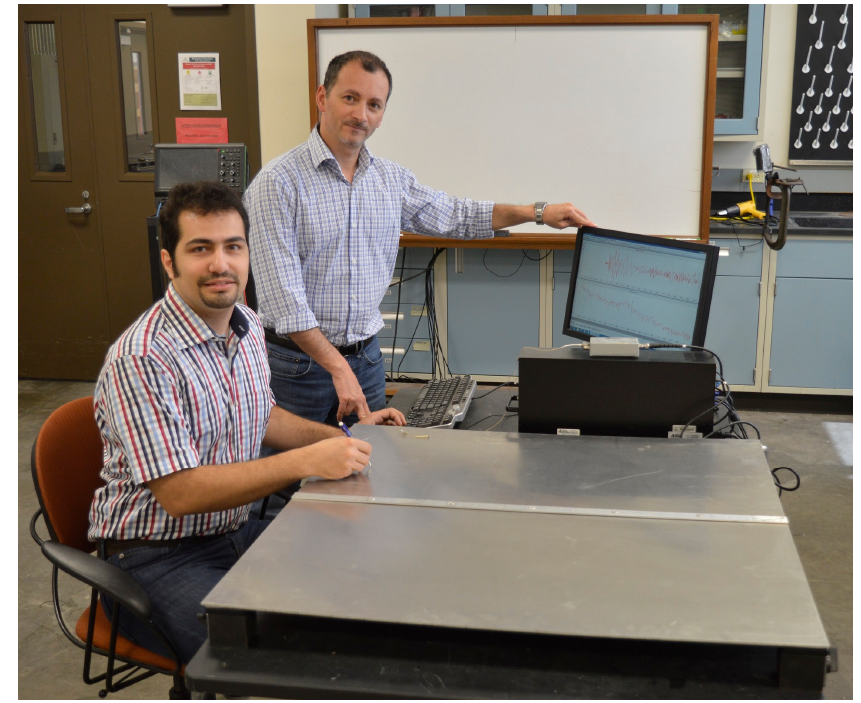
Figure 1. Dr. Ebrahimkhanlou and Dr. Salamone.